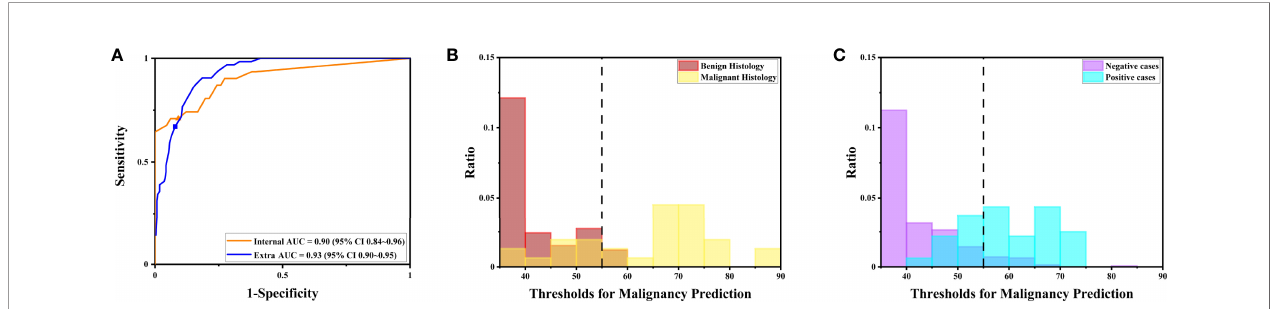
FIGURE 5 | The DLS performance to predict malignancy is illustrated. (A) The receiver operating characteristics curve for the performance to predict malignancy for the internal and extra tests. (B) The distribution of maximal possibilities in the internal test set. Most images from benign histology were scored below 55. (C) The distribution of maximal possibilities in the extra test set. Most images from negative cases were also scored below 55 (highlighted by the dashed line).